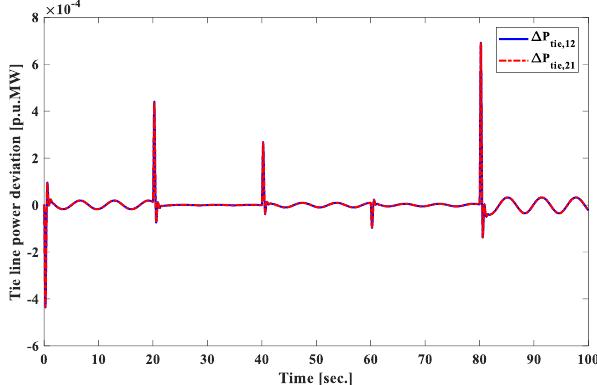
Figure 7. Tie line power deviation [p.u.MW] with matched disturbances.